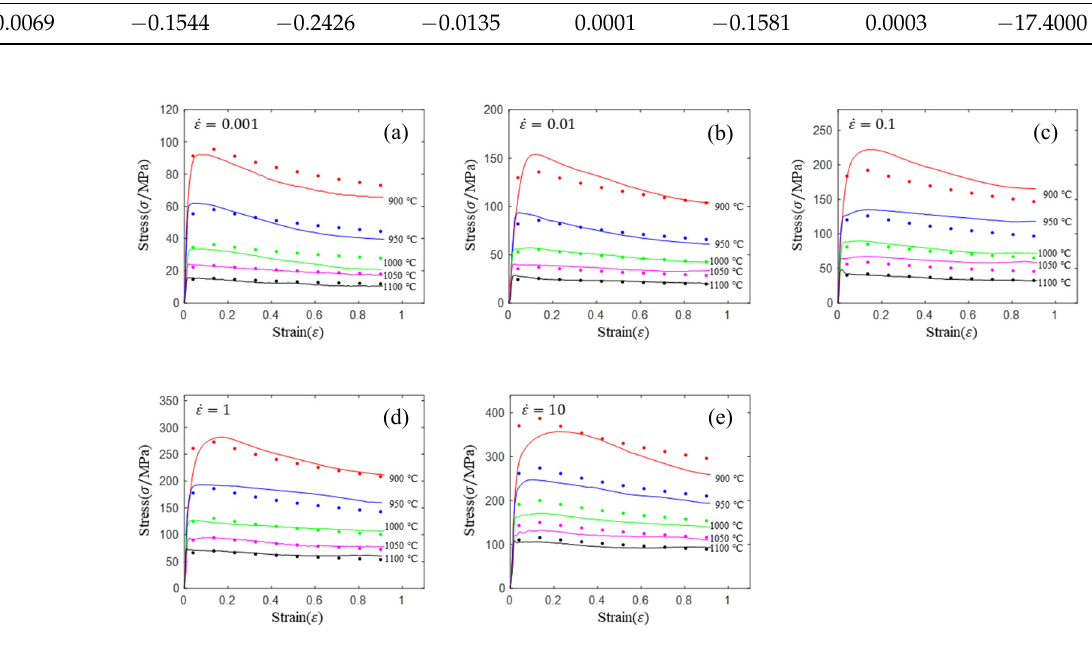
Figure 5. Comparison of prediction flow stress and experimental flow stress for HS model: ( a ) 0.01 s − 1